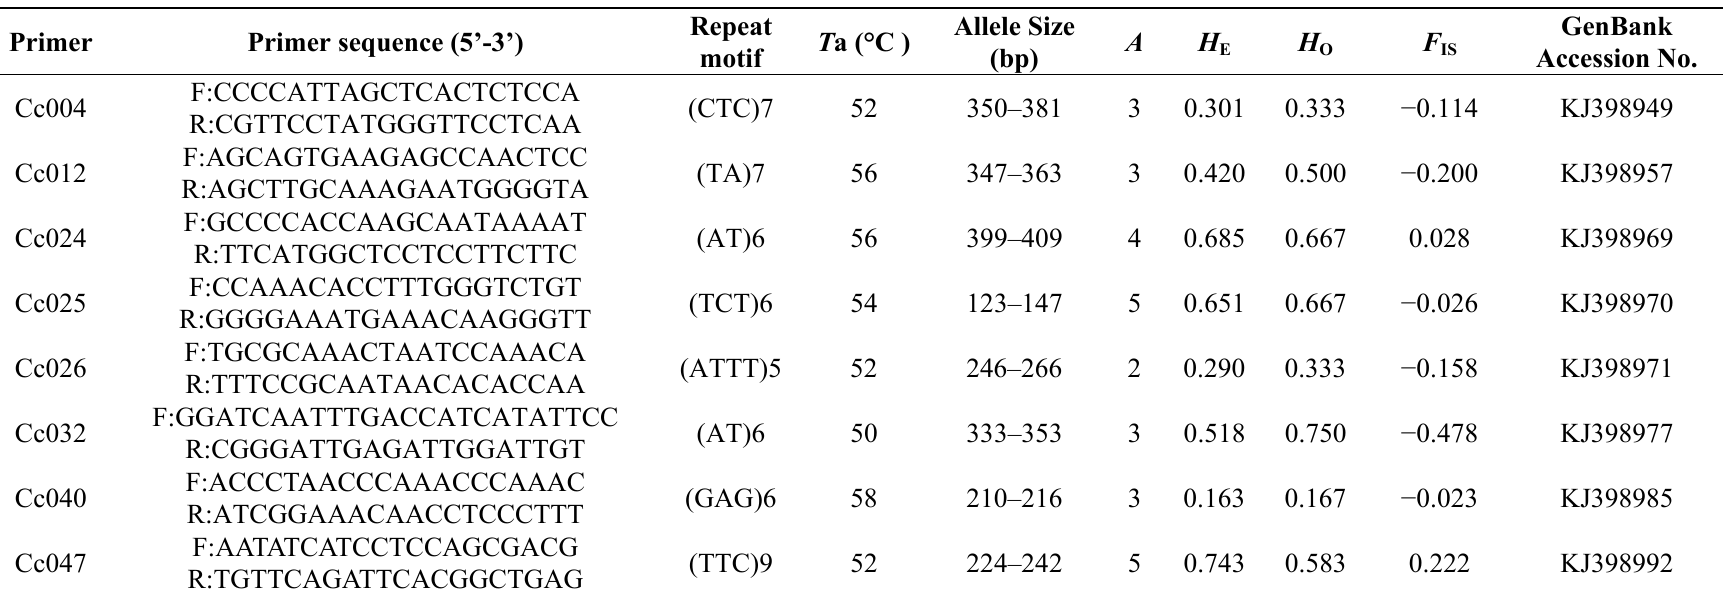
Table 1. Primer sequences and characterization for eight microsatellite loci isolated from Cotinus coggygria . Primer